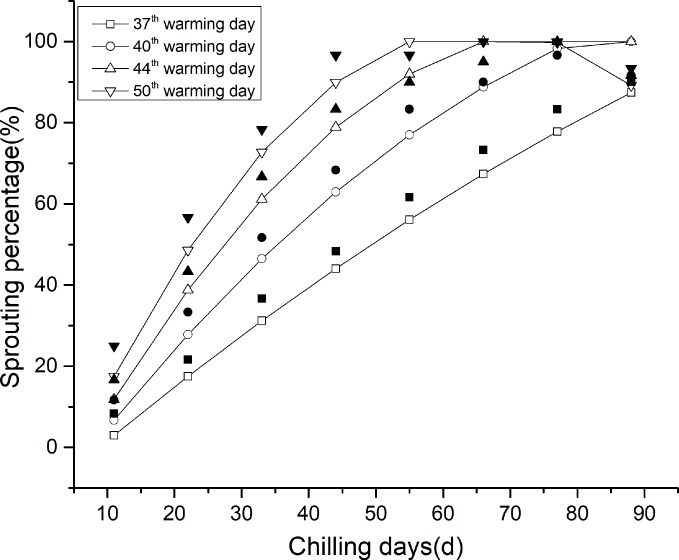
Validation of the CASkingianum model on the 37th, 40th, 44th and 50th warming day.The sprouting percentage we obtained from the verification experiment and the developed CASkingianum models are represented by solid and hollow shapes, respectively. The same shape represents the same warming day.